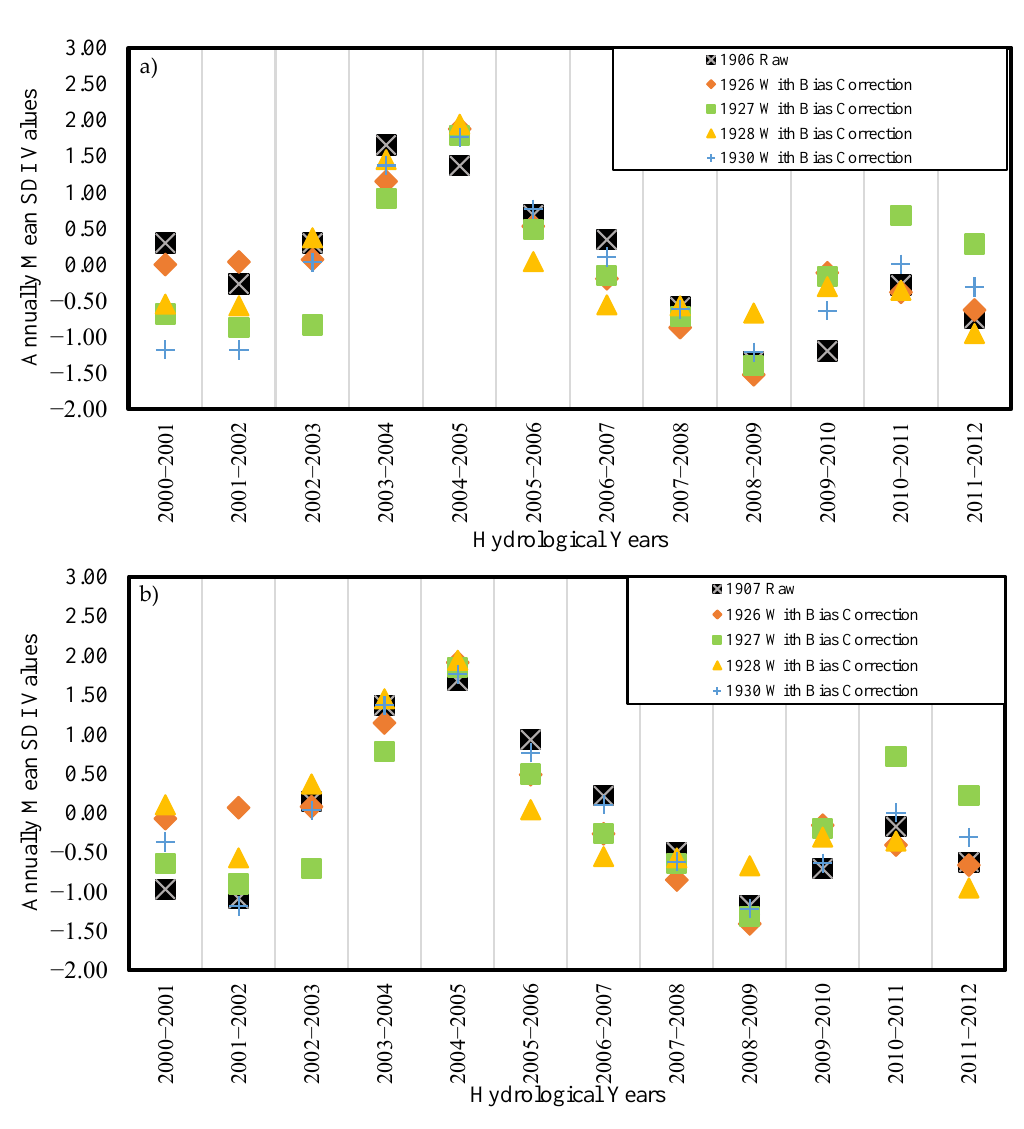
Figure 10. The mean annual SDI values for the raw (original) data and the other station data with bias correction. (a) 1906 comparisons, (b)1907 comparisons.